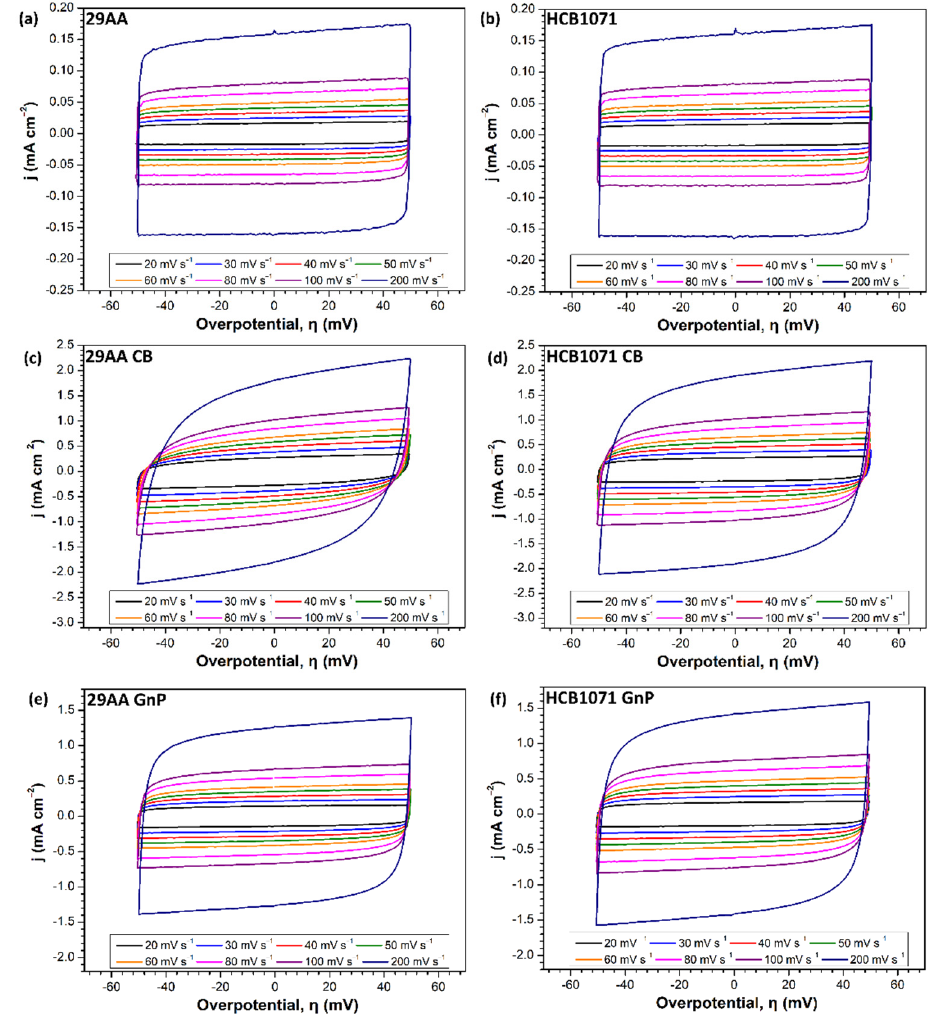
Figure 5. Cyclic voltammograms obtained on: ( a , b ) as received ( c , d ) carbon black (CB) and ( e , f ) GnP modified carbon paper (29AA) and carbon cloth (HCB1071) electrodes. Electrolyte, 1 M KCl. Temperature, 298 K. Table 1. Double-layer capacitance (C dl ), roughness factor (RF), and estimated ECSA of electrode materials. All values given to 3 s.f. Data taken from Figure